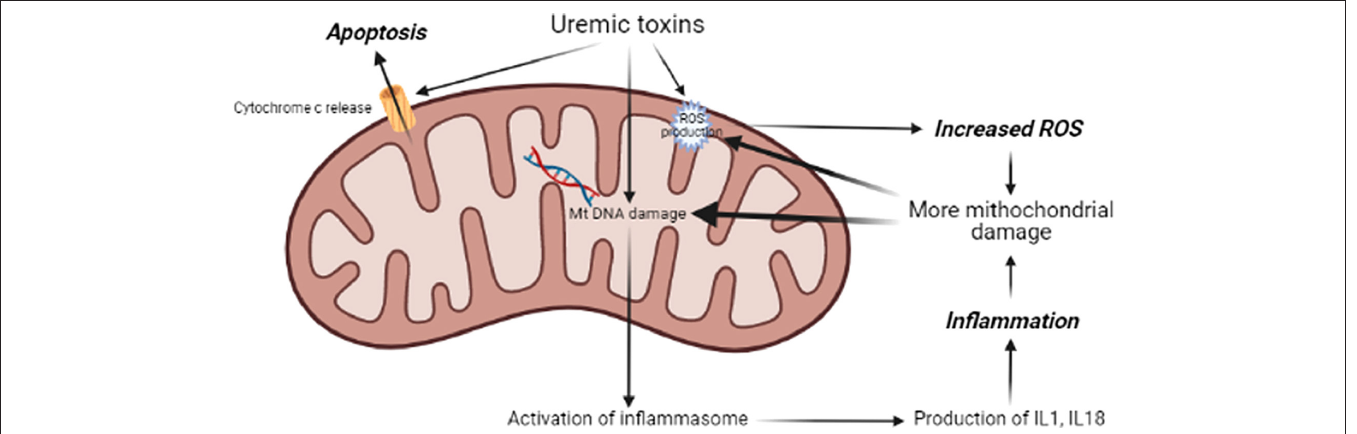
Figure 1. Dysfunctional mitochondria in patients with chronic kidney